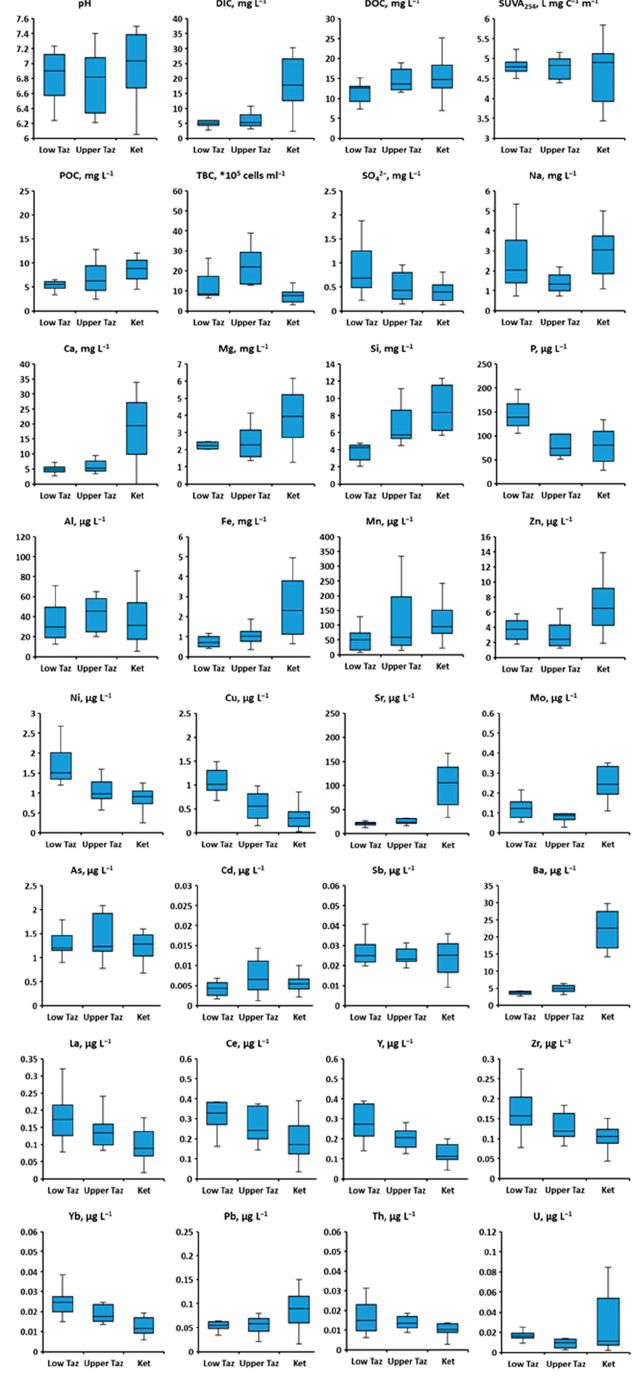
Figure 8. Elements concentration in Upper Taz (0–400 km from the mouth, northern part), Low Taz (400–800 km from the mouth, southern part), and Ket River (main stem and tributaries). Box represents median, whiskers correspond to lower and upper quartile.